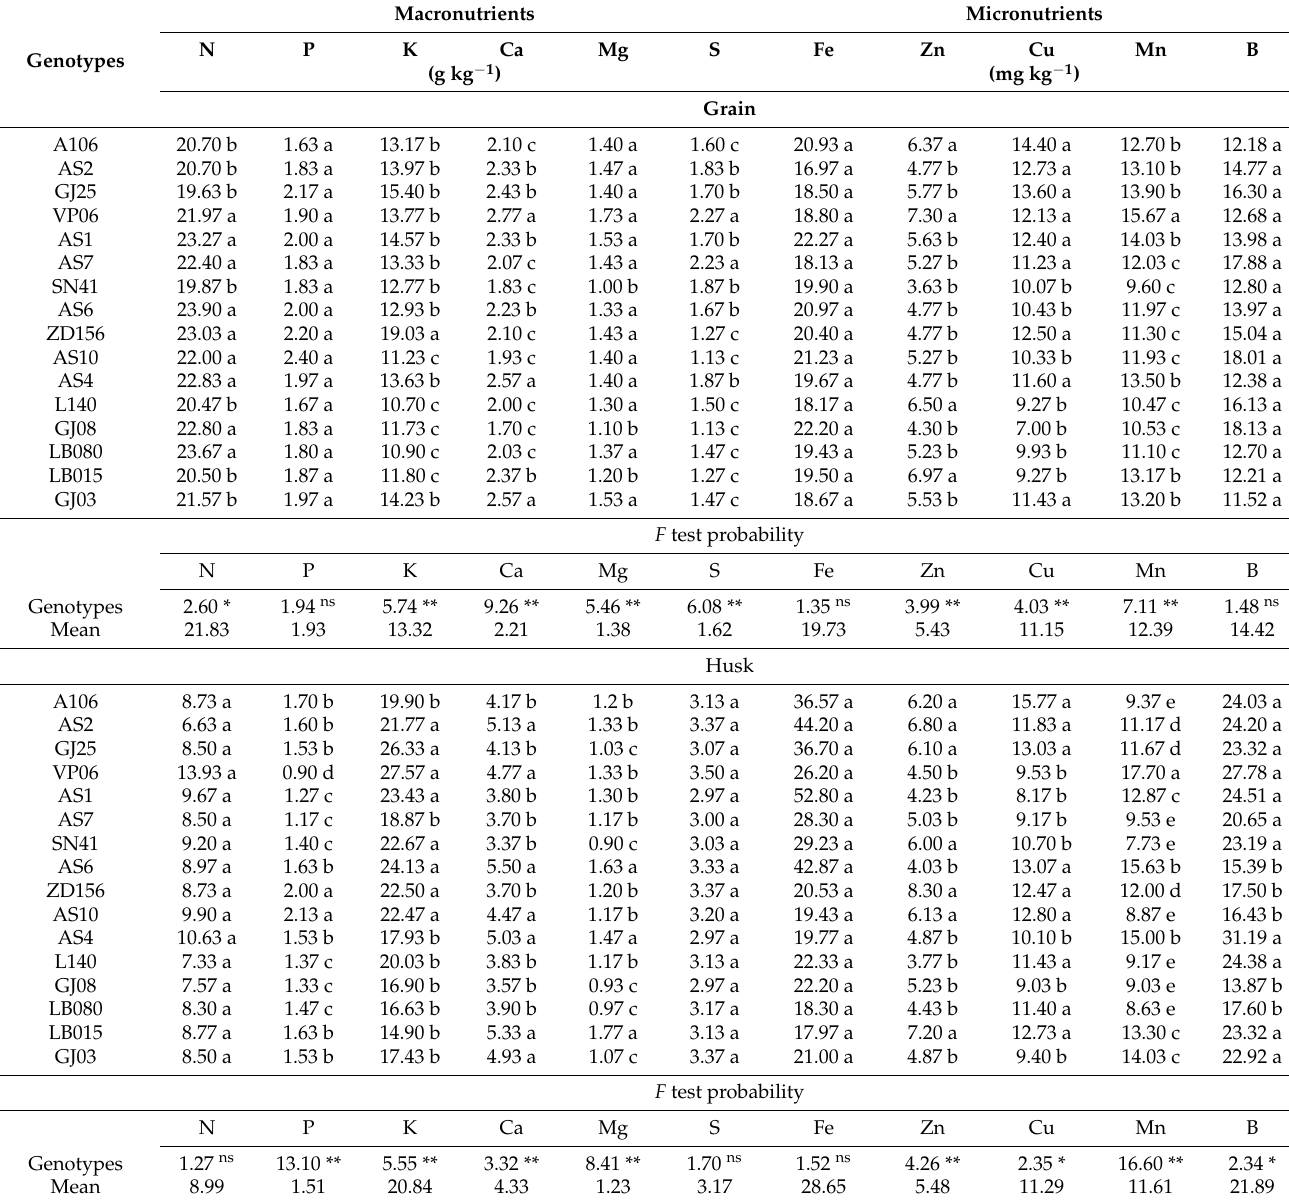
Table 6. Macro- and micronutrient concentrations in the grain and husk of 16 Coffea canephora genotypes. Alta Floresta D’Oeste, Rond ô nia,